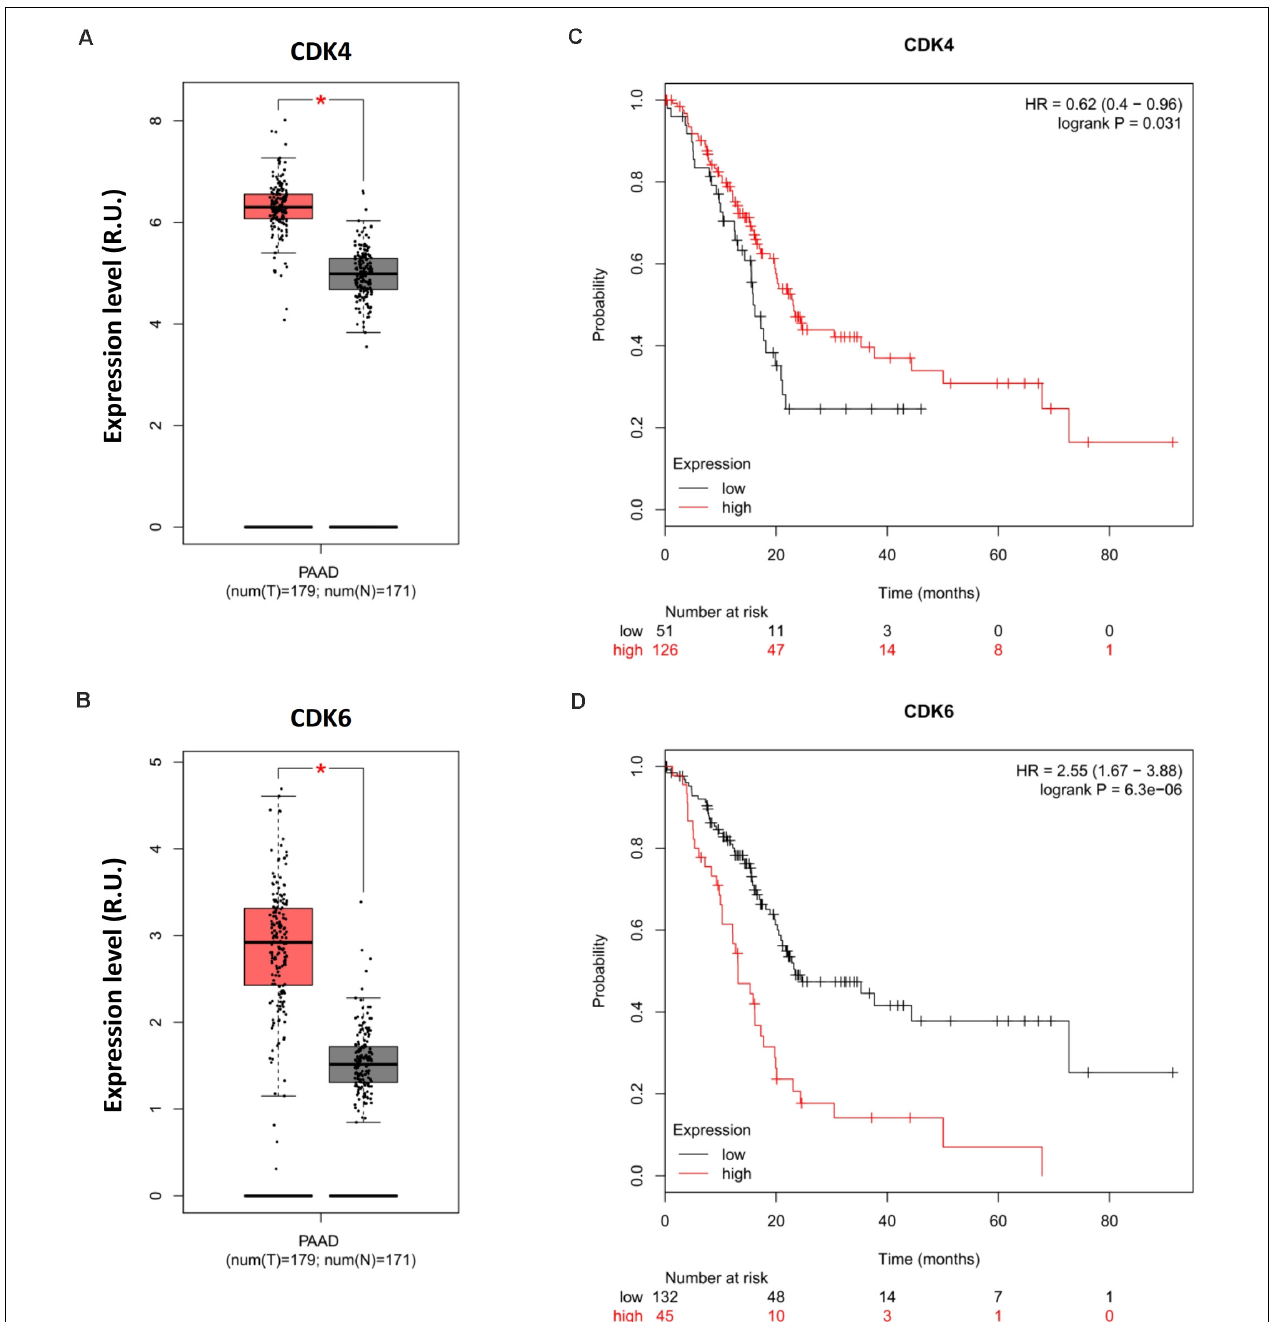
FIGURE 2 | Opposite prognoses of CDK4 and CDK6 in pancreatic cancer. Differential expression analysis of (A) CDK4 and (B) CDK6 in PAAD. OS analysis of (C) CDK4 and (D) CDK4 in PDA. P -values ≤ 0.05 were considered statistically significant. ∗ p ≤ 0 . 01.